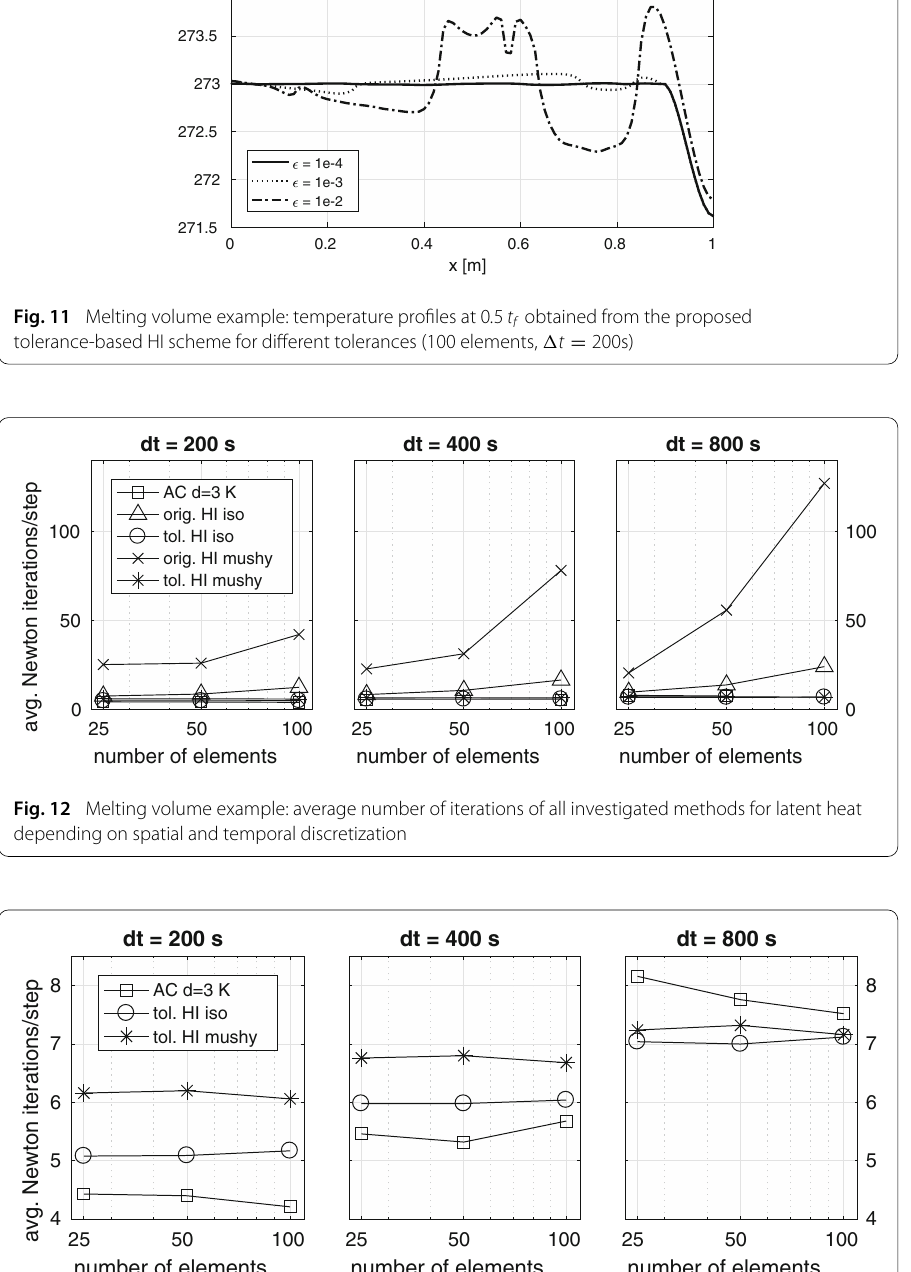
tive phase change intervals which would not be the main concern in PBFAM. Instead focus lies on the maximum temperature predicted on the left edge. For the smallest time step (cid:11) t = 200 s all widths reach almost the same maximum temperature. Increasing the step size leads to larger discrepancies in the maximum temperature. A smaller width